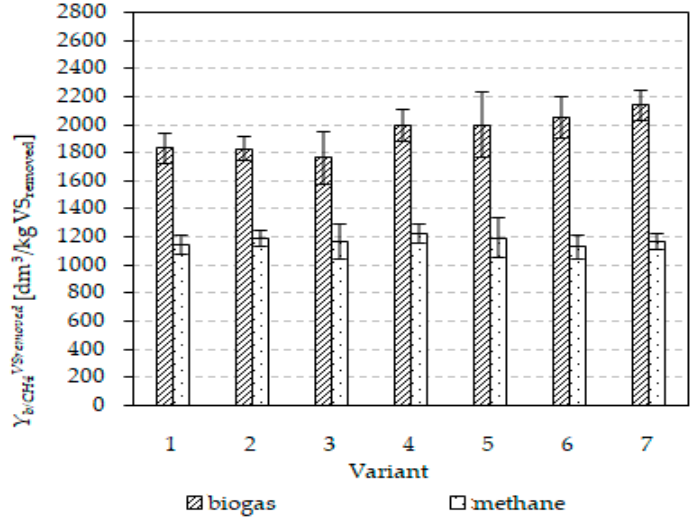
Figure 10. Biogas and CH 4 production in relation to VS removed.